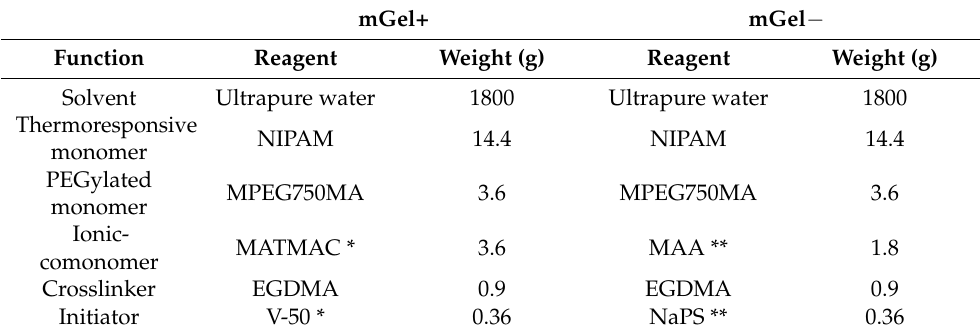
Table 1. Reagents and amounts used in the recipe for cationic and anionic microgels. mGel+ mGel − Function Reagent Weight